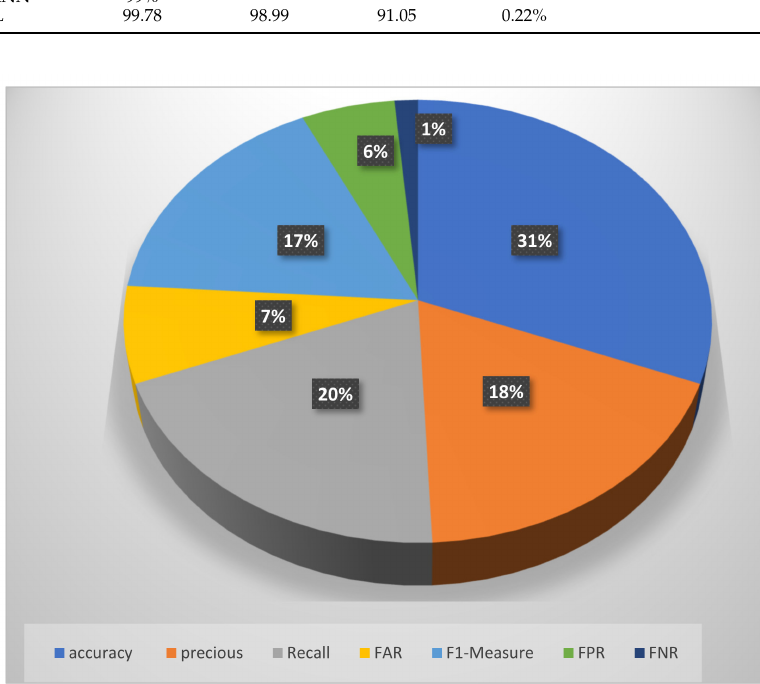
Figure 6. The frequency of performance measures of the